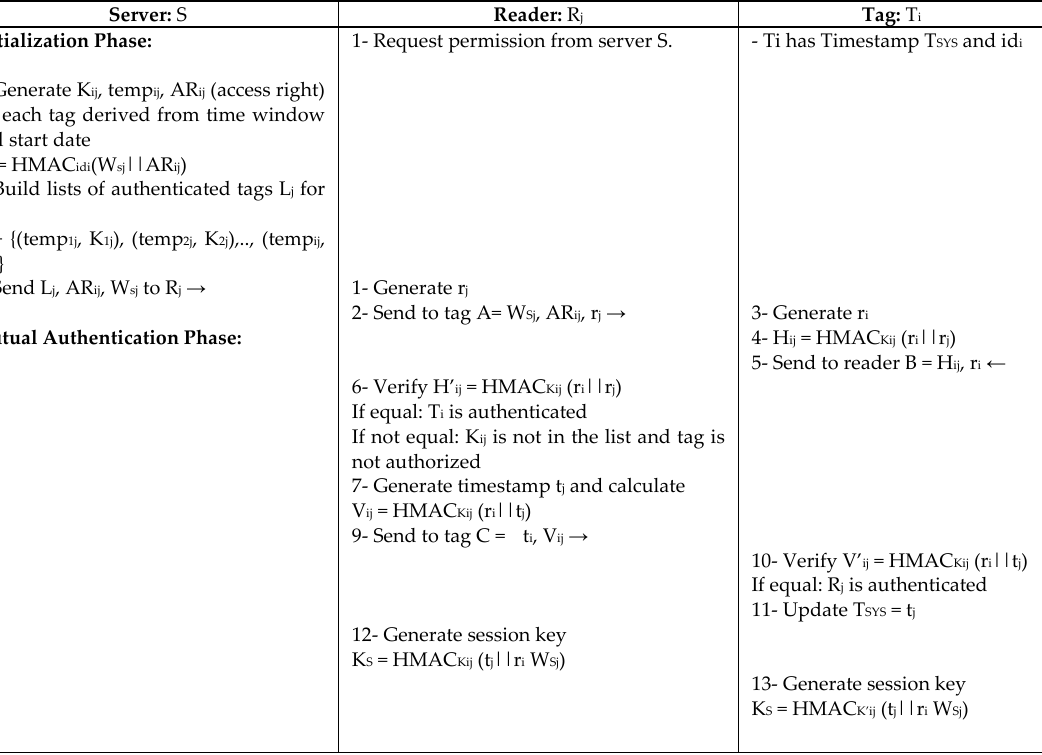
Figure 22. Serverless Security Authentication Protocol (SAP) by Mtita.